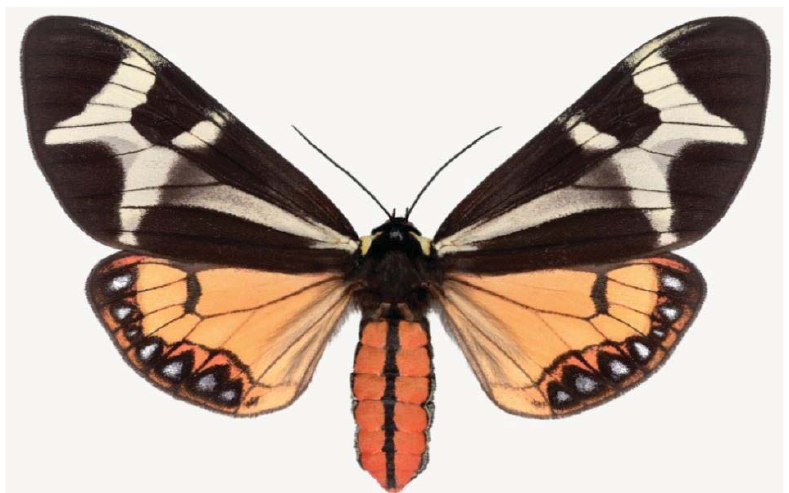
Figure 8. Dysschema howardi , an attractive tiger moth